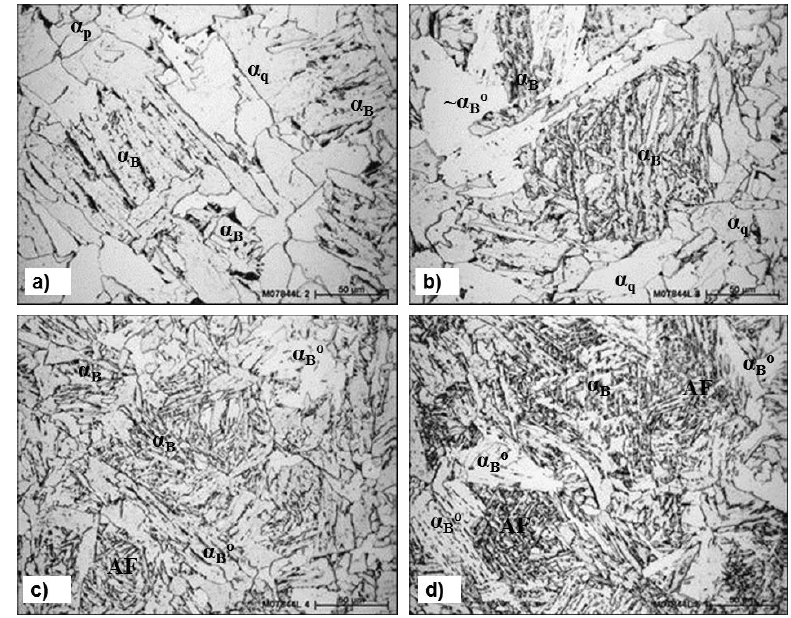
Figure 6. Optical microstructures for 0.014% Nb UCS dilatometer samples cooled at ( a ) 3 °C/s some α q , predominately α B , ( b ) 10 °C/s ~α q , predominately α B + ~α B °, ( c ) 30 °C/s, α B + α B ° + AF and (d) 60 °C/s α B + α B ° +